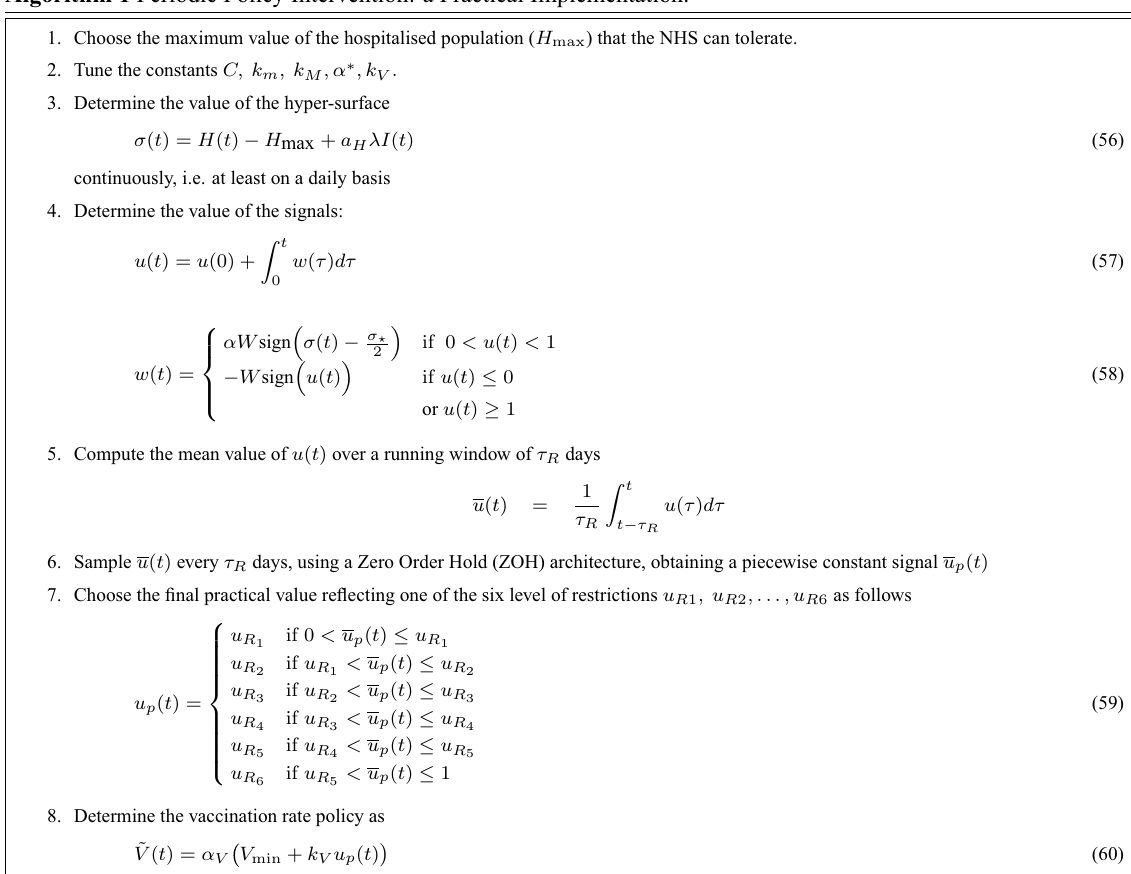
Algorithm 1 Periodic Policy Intervention: a Practical